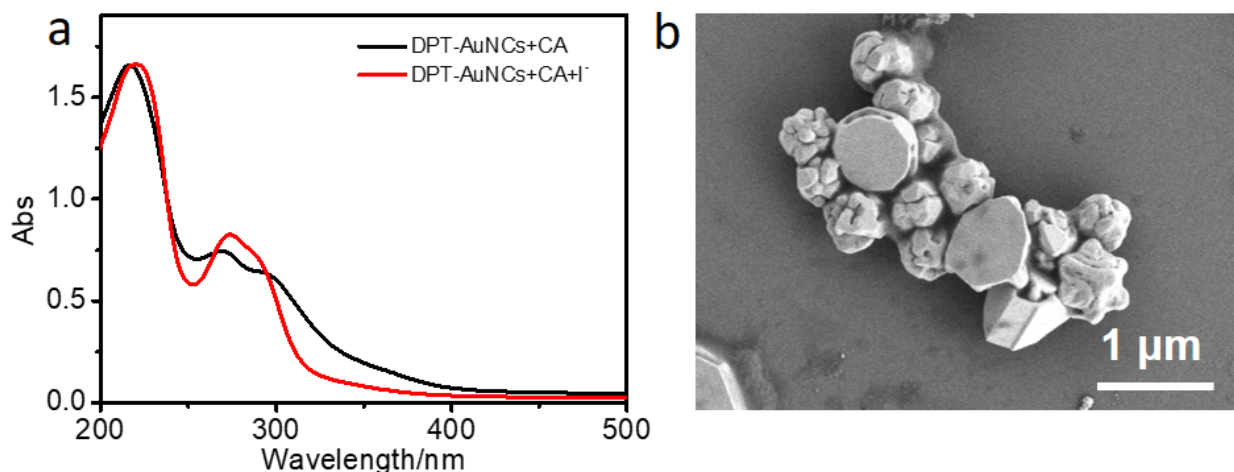
Figure 3. ( a ) UV-vis spectra of samples constituted by CA/DPT-AuNCs and CA/DPT-AuNCs/I − . ( b ) SEM image of CA/DPT-AuNCs/I − .